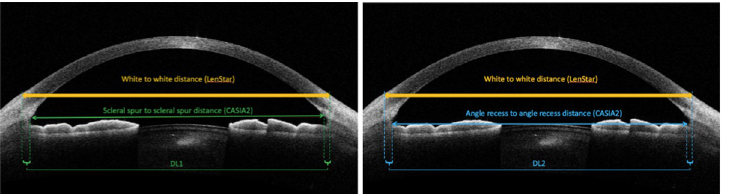
Fig 1. Image of anterior chamber in horizontal meridian using CASIA2 anterior segment optical coherence tomography. DL1 is the displacement lengths of white-to-white distance minus scleral spur-to-scleral spur distance. DL2 is the displacement lengths of white-to-white distance minus angle-to-angle